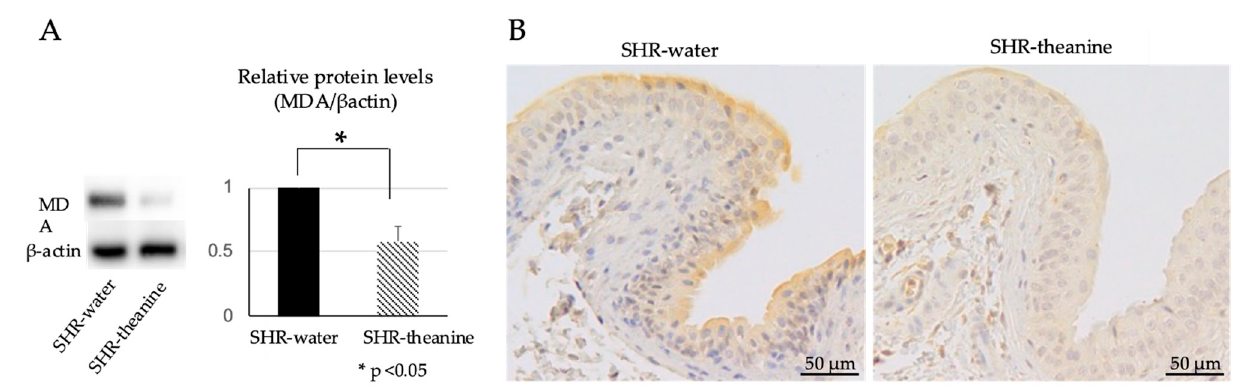
Figure 5. Summary of bladder oxidative levels in SHR treated with water and treated with L-theanine: ( A ) relative MDA protein levels in bladder and Western blots. Protein expression level of the bladder was significantly lower in the SHR– theanine group than in the SHR–water group. * Statistical significance at the p < 0.05 level; ( B ) immunohistochemical staining of the bladder in SHR–water and SHR–theanine groups, scale bars = 200 µm. Expression of MDA in the bladder was weaker in the SHR–theanine group than in the SHR–water group.